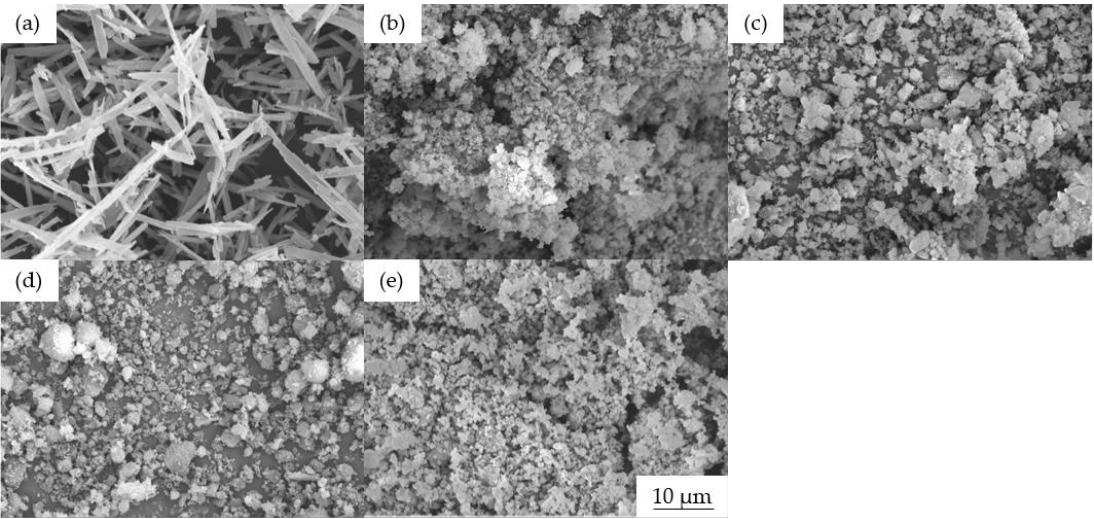
Figure 3. SEM images of the colorants ( a ) alizarin, ( b ) pigment blue 15:1, ( c ) pigment green 7, ( d ) pigment pink PR122, and ( e ) pigment yellow 155.